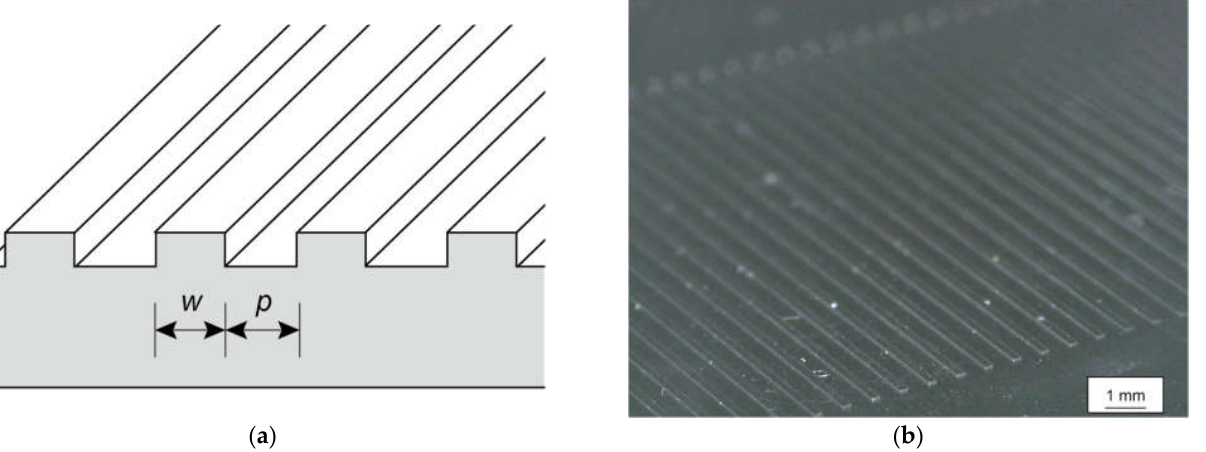
Figure 1. Tactile samples used for roughness perception experiments. ( a ) Cross-sectional schematic where w and p are the ridge and groove widths, respectively. The ridge height was 50 µ m. ( b ) Microscopy image of sample texture.